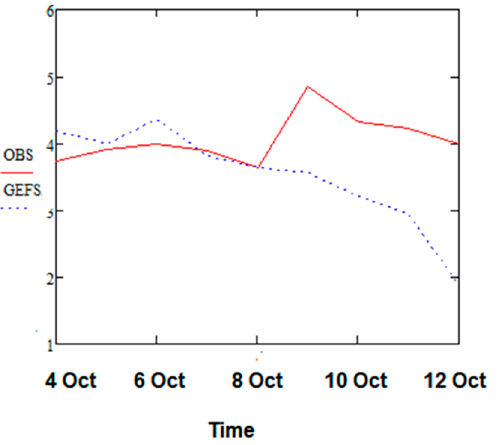
Figure 5. The Strong Atlantic blocking event observed BI (red—solid) and GEFS model BI (blue dotted) for the one-day GEFS ensemble mean forecast